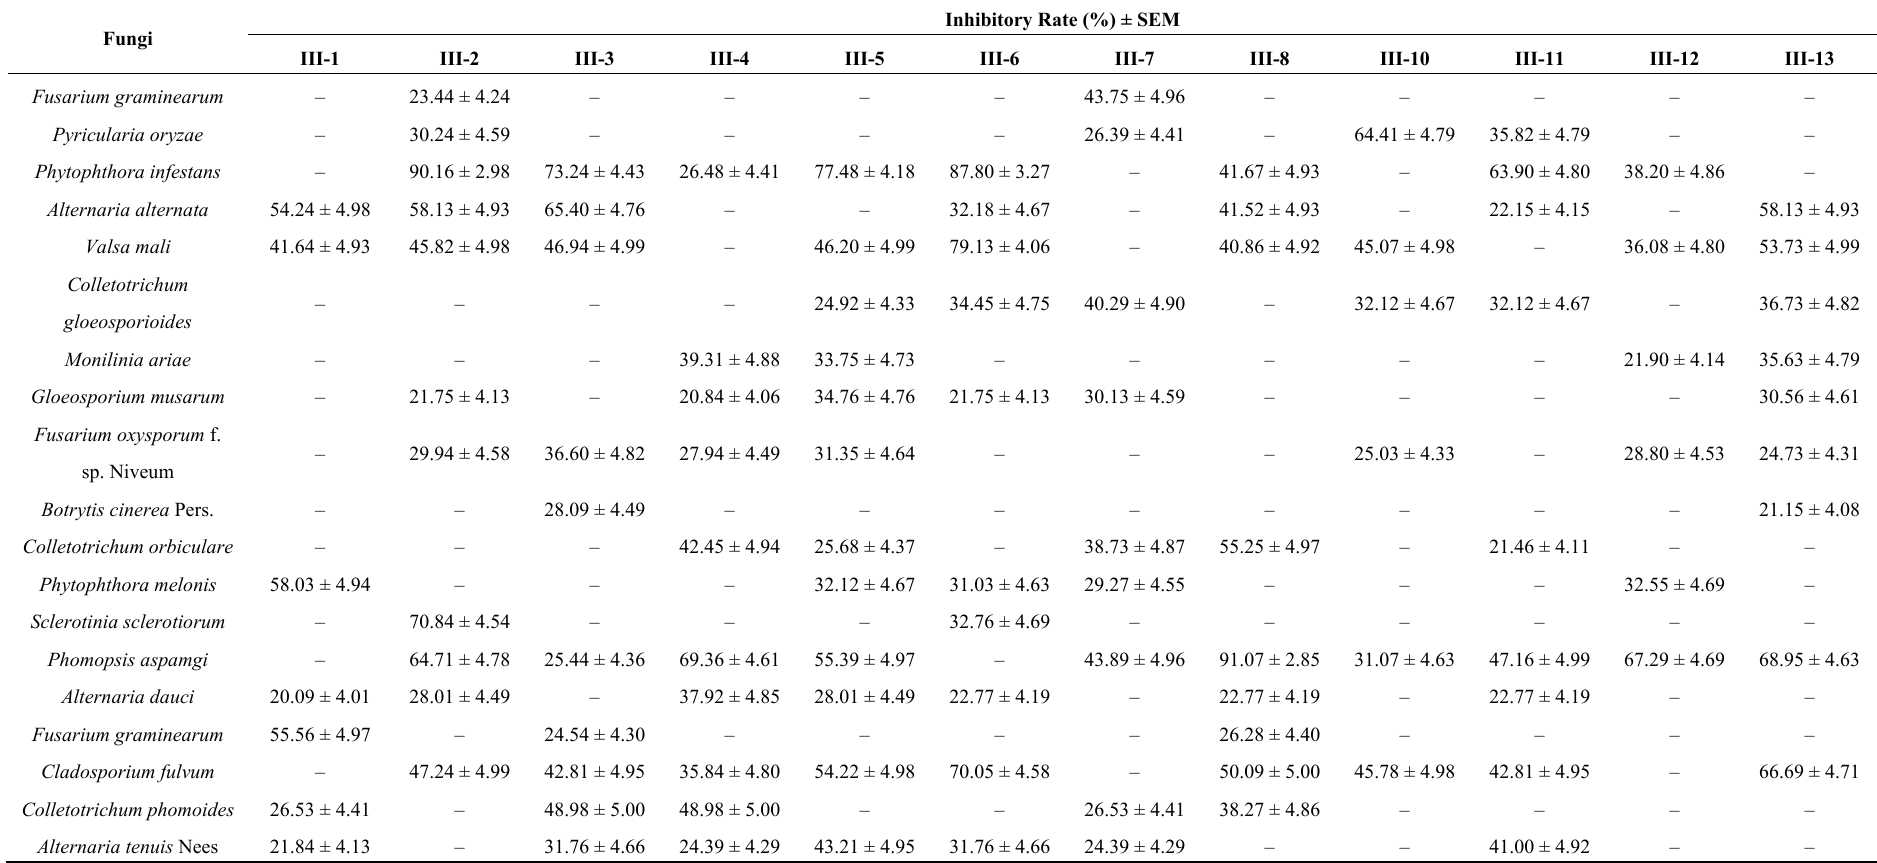
Table 2. The preliminary bioassay against 19 fungi at 50 μg·mL −1